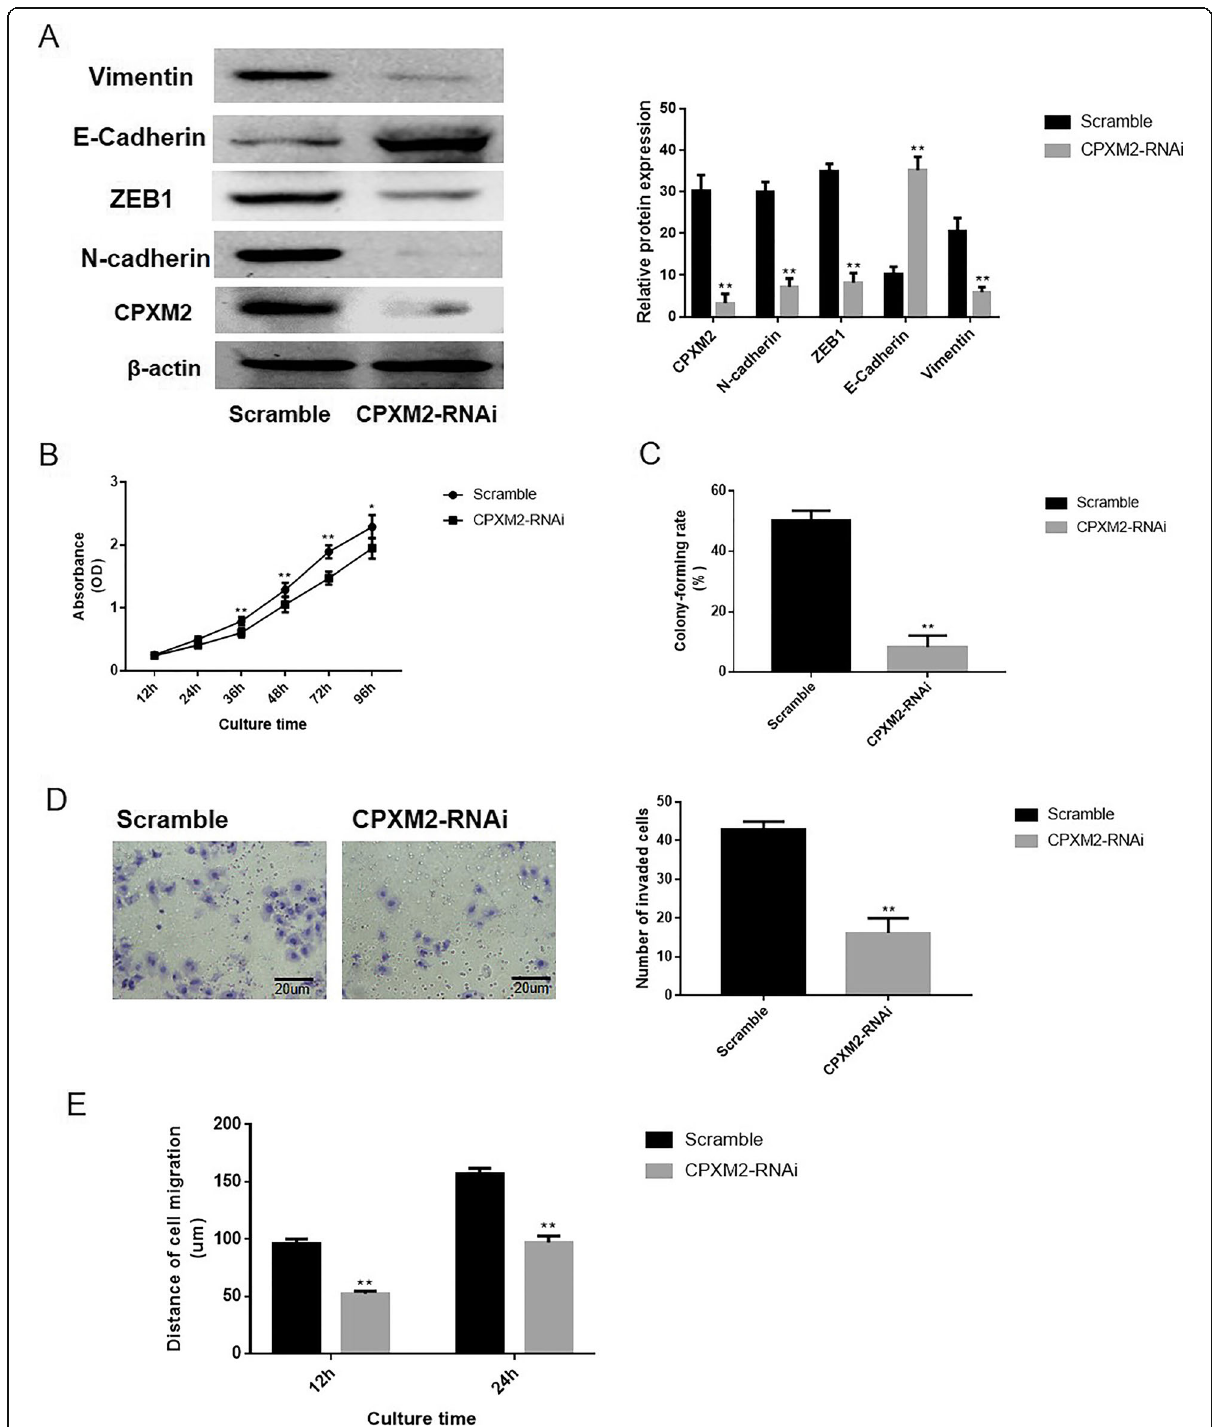
Fig. 4 Loss of CPXM2 decreased the on the proliferation and migration ability of osteosarcoma U2OS cells. a Western blotting was used to examine the effects of silencing CPXM2 and EMT process in the osteosarcoma U2OS cells. b Growth curve of osteosarcoma cells detected by the CCK-8 assay. c The abilities of osteosarcoma cells to form colonies under 2D culture condition were determined through colony formation assay. d The Transwell chambers method was utilized to explore the impact of CPXM2 silence on the invasive ability of osteosarcoma U2OS cells in vitro. e The wound-healing assay was utilized to explore the migration ability of osteosarcoma cells in vitro. ** P < 0.01, compared with the scramble group. CPXM2, Carboxypeptidase X, M14 family member 2; EMT, epithelial mesenchymal transition; OD, optical